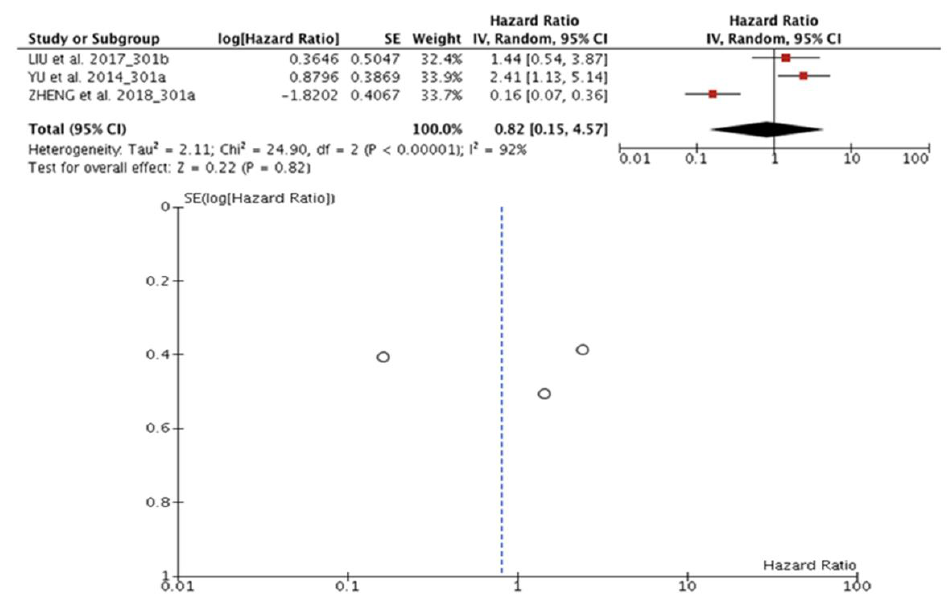
Figure 6. miR-301 and prognosis in TNBC. Forest and funnel plot observed effect of miR-301 a/b expression on OS in TNBC was not significant (HR: 0.82; 95% CI: 0.15 – 4.57; I2 = 92%, p < 0.00001), Z = 0, 22, ( p = 0.82) [29,68,74].